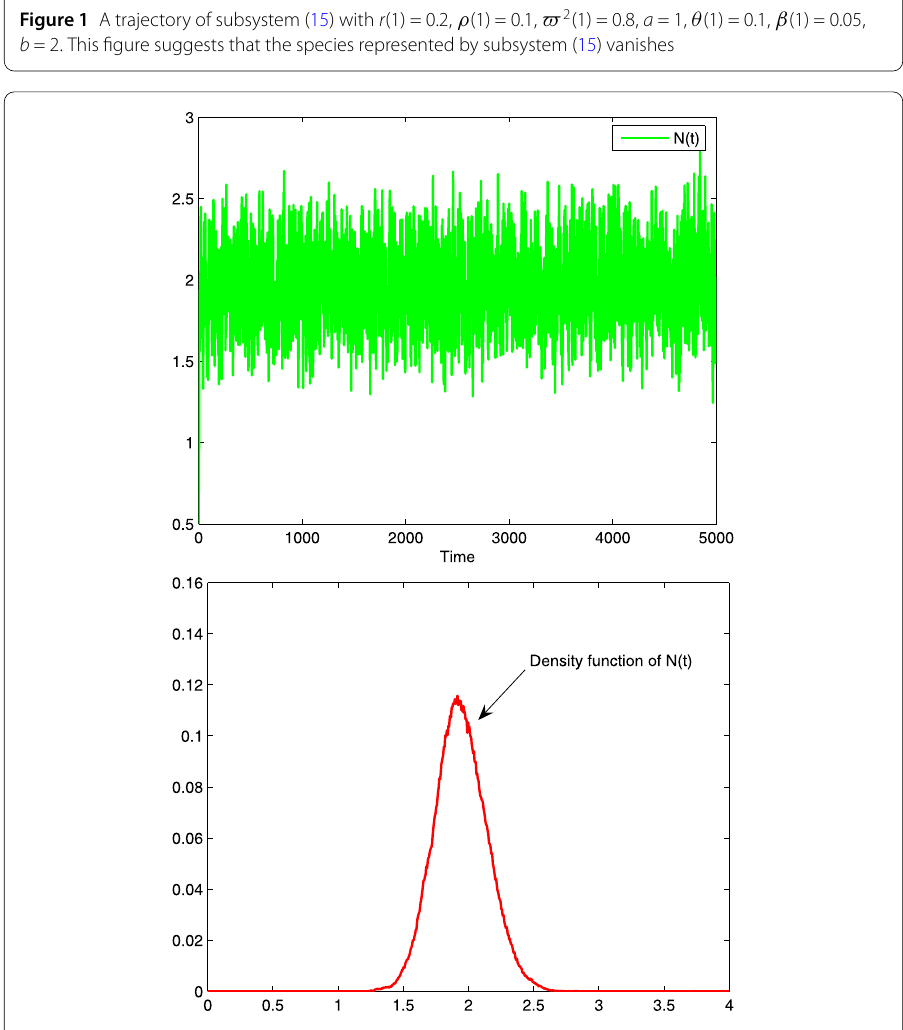
Figure 2 Subsystem (16) with r (2) = 0.2, ρ (2) = 0.1, (cid:5) 2 (2) = 0.2, a = 1, θ (2) = 0.1, β (2) = 0.05, b = 2. ( a ) is a trajectory of the system which suggests that the system is persistent; ( b ) is the density function of the solution of the system t =